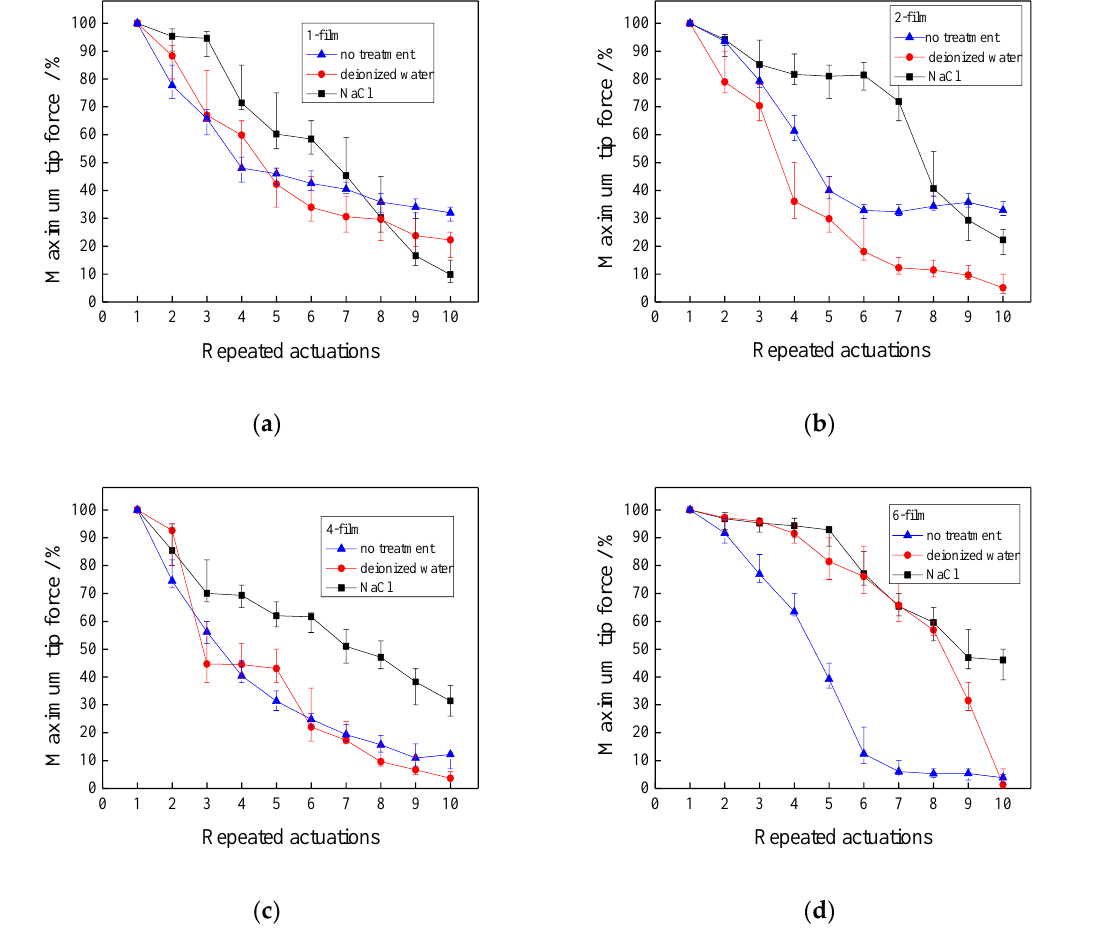
Figure 9. Maximum tip forces when the IPMCs with various thicknesses are repeatedly actuated. ( a ) 1-film; ( b ) 2-film; ( c ) 4-film; ( d ) 6-film.